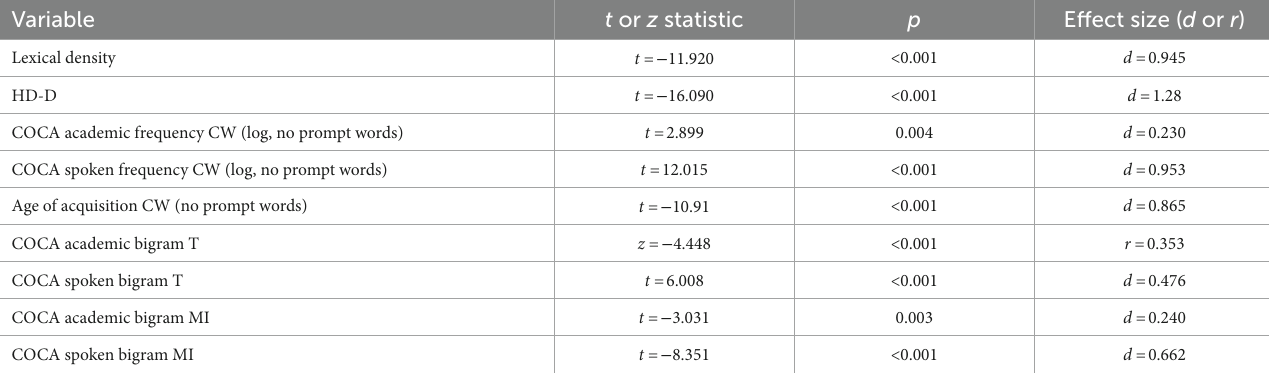
TABLE 2 T statistics for t -test results (or z statistics for Wilcoxon signed-rank test results) for lexical and phraseological features between L2 written and spoken responses in the training set ( n = 318). Variable